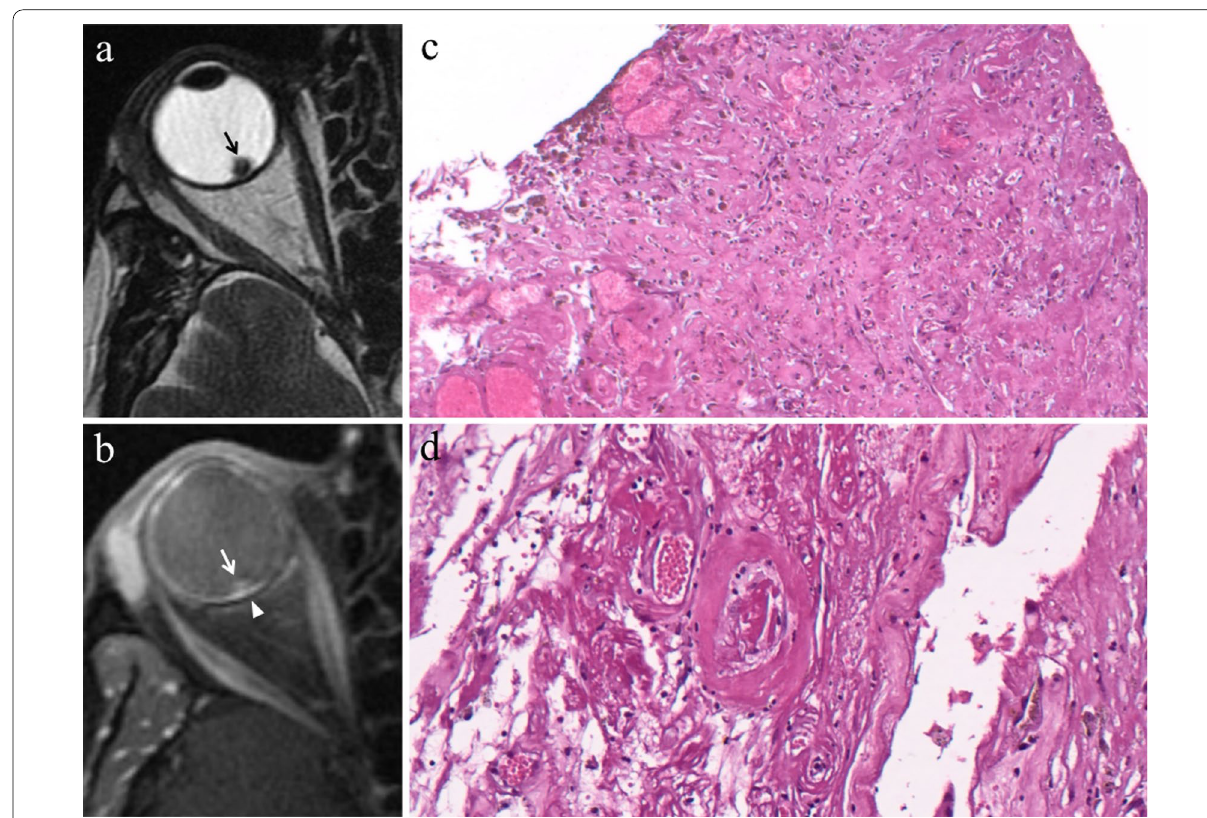
Fig. 6 A 58-year-old man with residual fibrotic scar after proton-beam radiotherapy for choroidal melanoma of the right eye. The patient underwent secondary enucleation two years after radiotherapy because of neovascular glaucoma. a Axial T2-weighted turbo spin-echo STIR image demonstrates an intraocular small rounded hypointense mass along the posterior aspect of globe (black arrow). On b contrast-enhanced fat-suppressed T1-weighted image, the mass exhibits mild enhancement (white arrow). Note the pronounced enhancement of the choroid below the irradiated lesion due to radiation-related neoangiogenesis (white arrowhead). c Histological examination showing a well-circumscribed sclero-hemorrhagic nodule composed of ectatic vessels, fibrosis with scattered reactive fibroblasts and abundant component of melanophages; no neoplastic cells are visible (H&E, original magnification 200 ). d On higher magnification, within the choroid below the abovementioned nodule, × ectatic and thick-walled vessels are evident (H&E, original magnification 400 ×